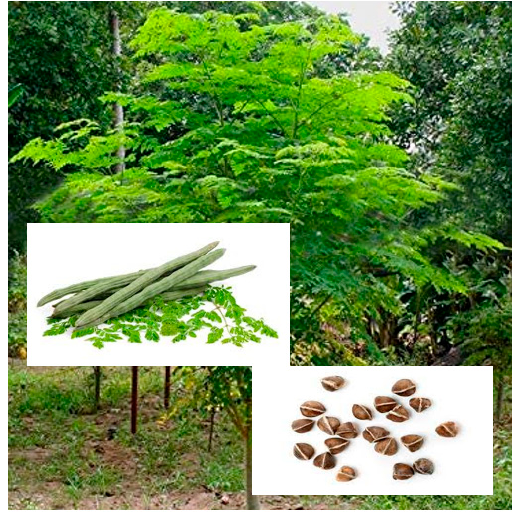
Figure 6. Moringa plant, pods, and seeds.